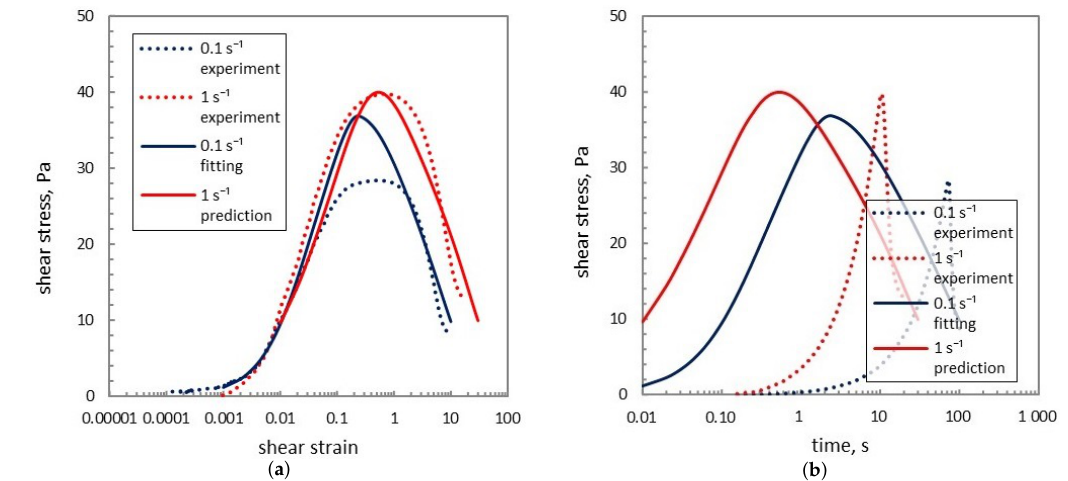
Figure 13. Model predictions of shear stress as a function of shear strain and of time using constant shear rate ˙ γ without inertial delay: ( a ) shear stress as a function of shear strain; ( b ) shear stress as a function of time.